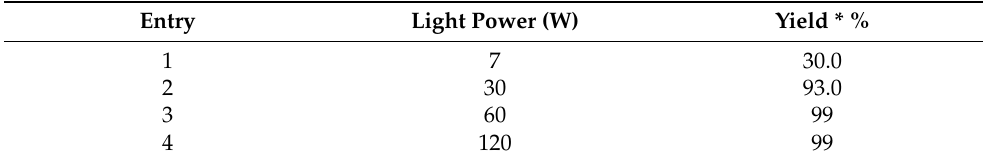
Figure 4. Effects of reaction time on the conversion of benzyl alcohol. Table 3. Benzyl alcohol oxidation with different light power.